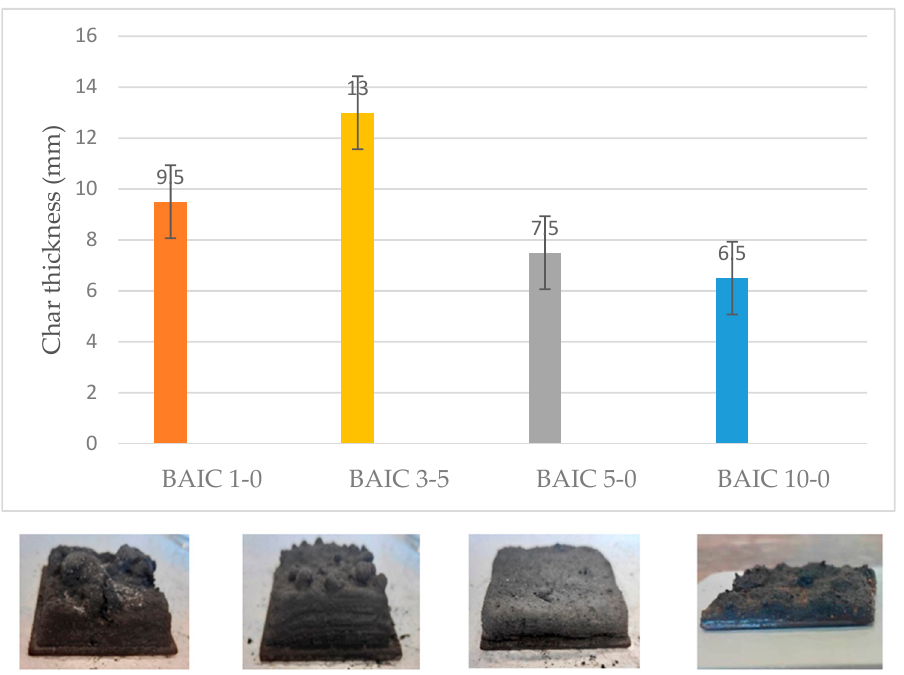
Figure 4. Char thickness (mm) of BAIC samples.